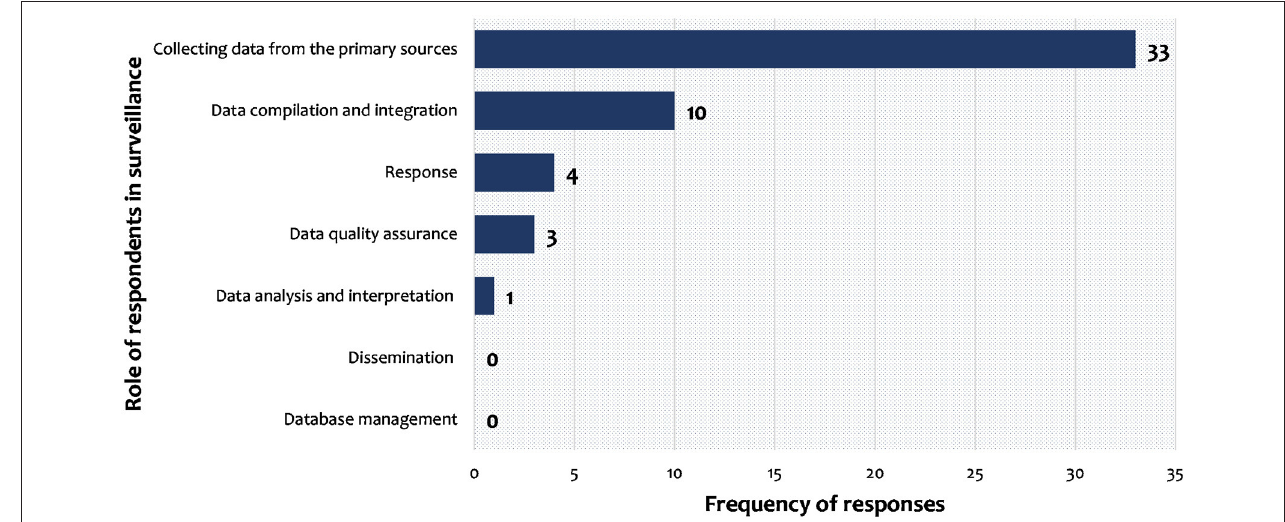
FIGURE 6 | Role played by respondents in surveillance activities.